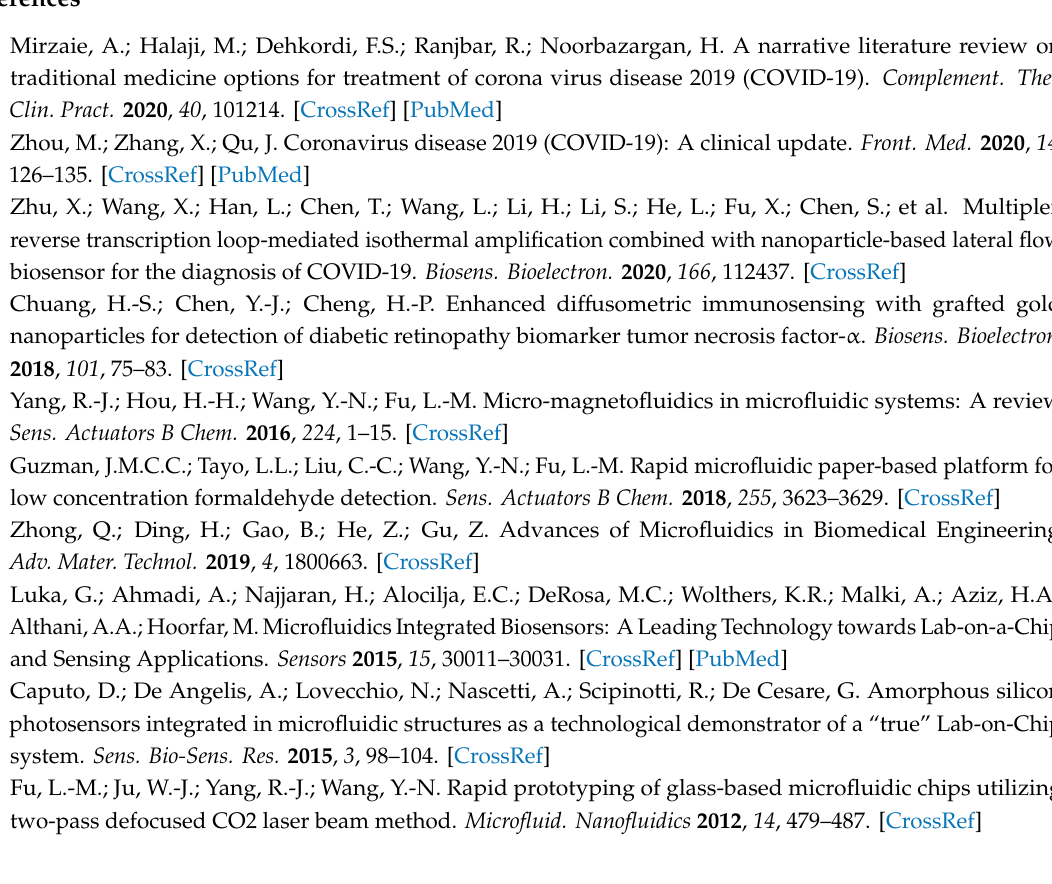
Figure S1. Porous hydrogel fabrication: PS particles removal. Figure S2. Porous hydrogel relocation to new capillary tube. Figure S3. Backlight Optimization. Figure S4. (a) Image taken inside the detection box. (b)